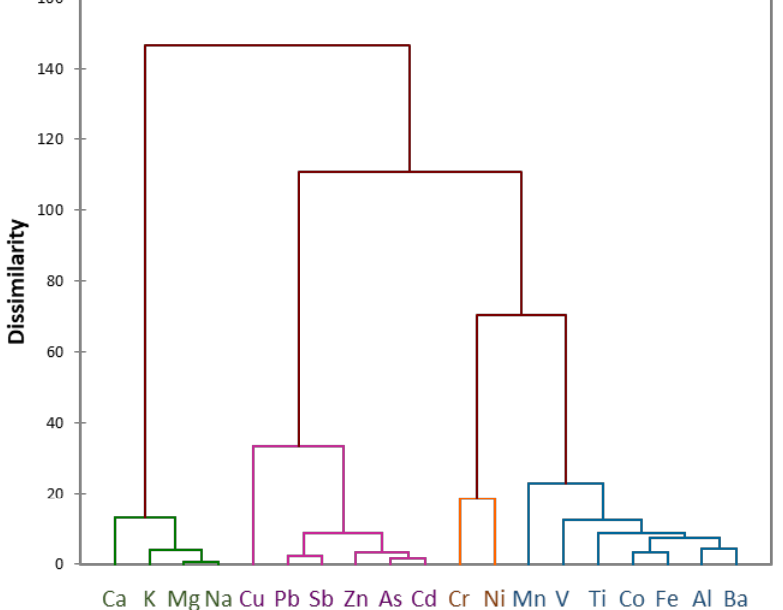
Figure 2. Dendrogram obtained by HCA on the results of the direct digestion of all PM 10 samples collected in 2015.